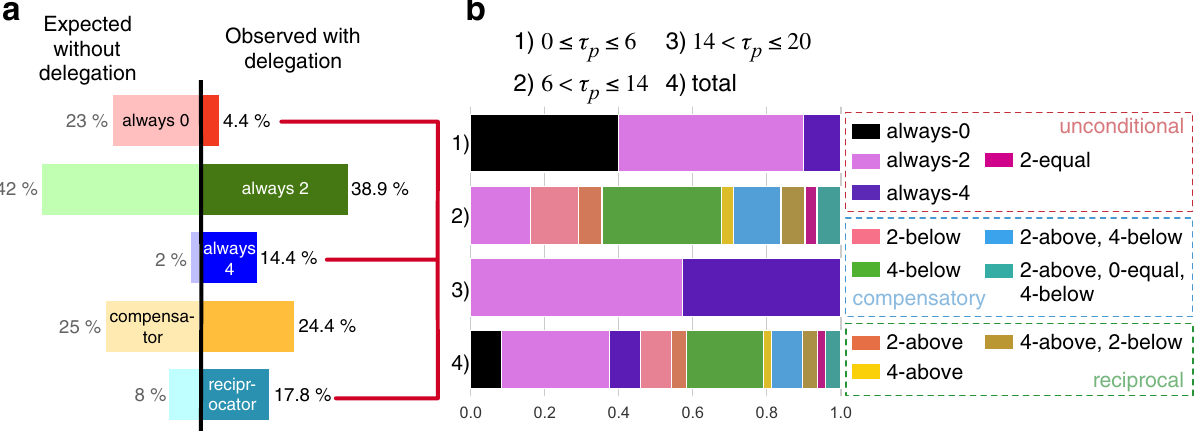
Figure 2. Delegation bias. Panel ( a ) shows the distribution of agent behaviors chosen by the participants (right of the black line) in the delegate treatment ( n = 90 ) in comparison to the expected values predicted by the Fernández Domingos et al. model 19 (left of the black line). The observed values indicate that there is a bias toward behaviors that are beneficial for the success of the group. Distribution of agent configurations in the customize treatment. Panel ( b ) displays the distribution of configurations for the three levels of personal threshold and in total ( n = 10 , n = 31 , n = 7 and n = 48 , respectively). Always-0 only appears for participants that configured low values of τ p , while participants that selected high values of τ p choose always-4 with a similar frequency than always-2. The biggest variety of configurations is observed for intermediate levels of τ p where participants give preference to conditional behaviours and select with higher frequency a 4-below (compensatory) configuration. In general, the most frequent behaviours are always-2 and